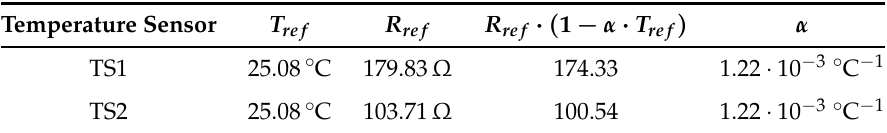
Table 3. TCR calculations based on Equation (2) and the intercept with the y-axis in Figure 11.